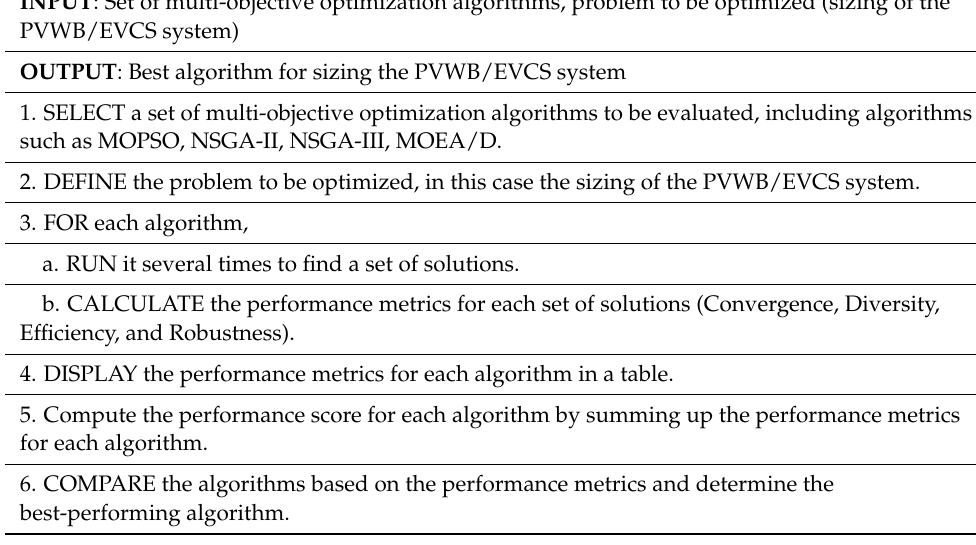
Algorithm 5: Performance Evaluation of Multi-Objective Optimization